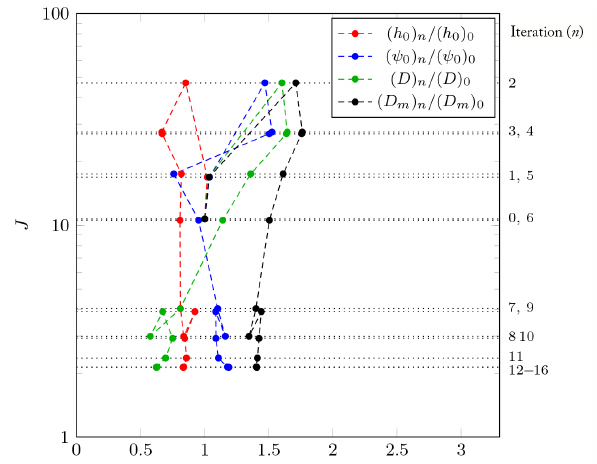
Figure 9. Values of the parameters from the model with both mud and sand sediment classes over the optimisation iterations against the value of the objective functional, J , that we are aiming to min- imise. The values shown are normalised by their starting values.